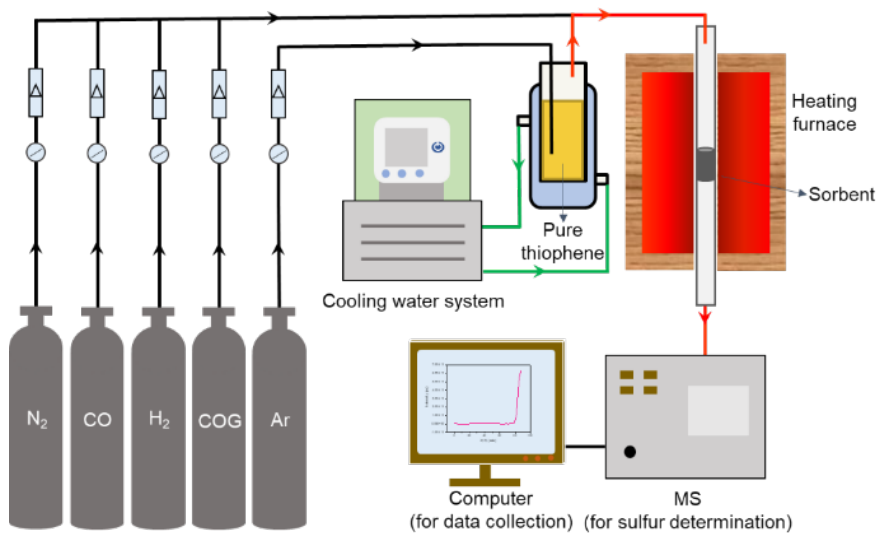
Table 1. Composition of simulated COG.